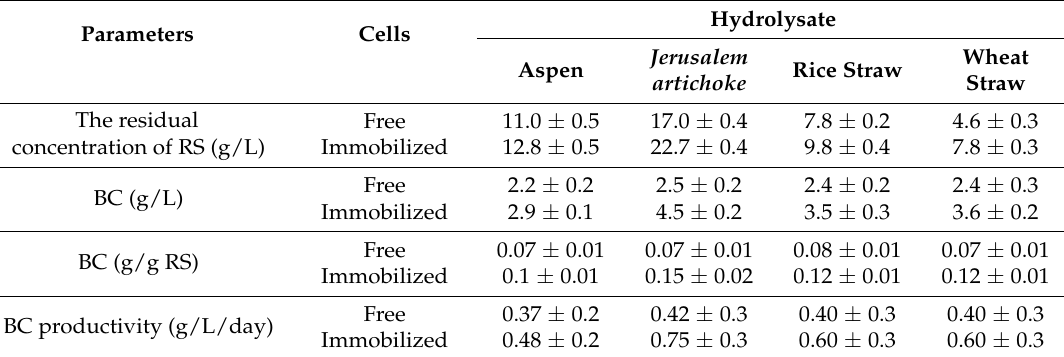
Table 3. The production of BC by free and immobilized cells in media with hydrolysates of renewable raw materials. RS, reducing sugars.